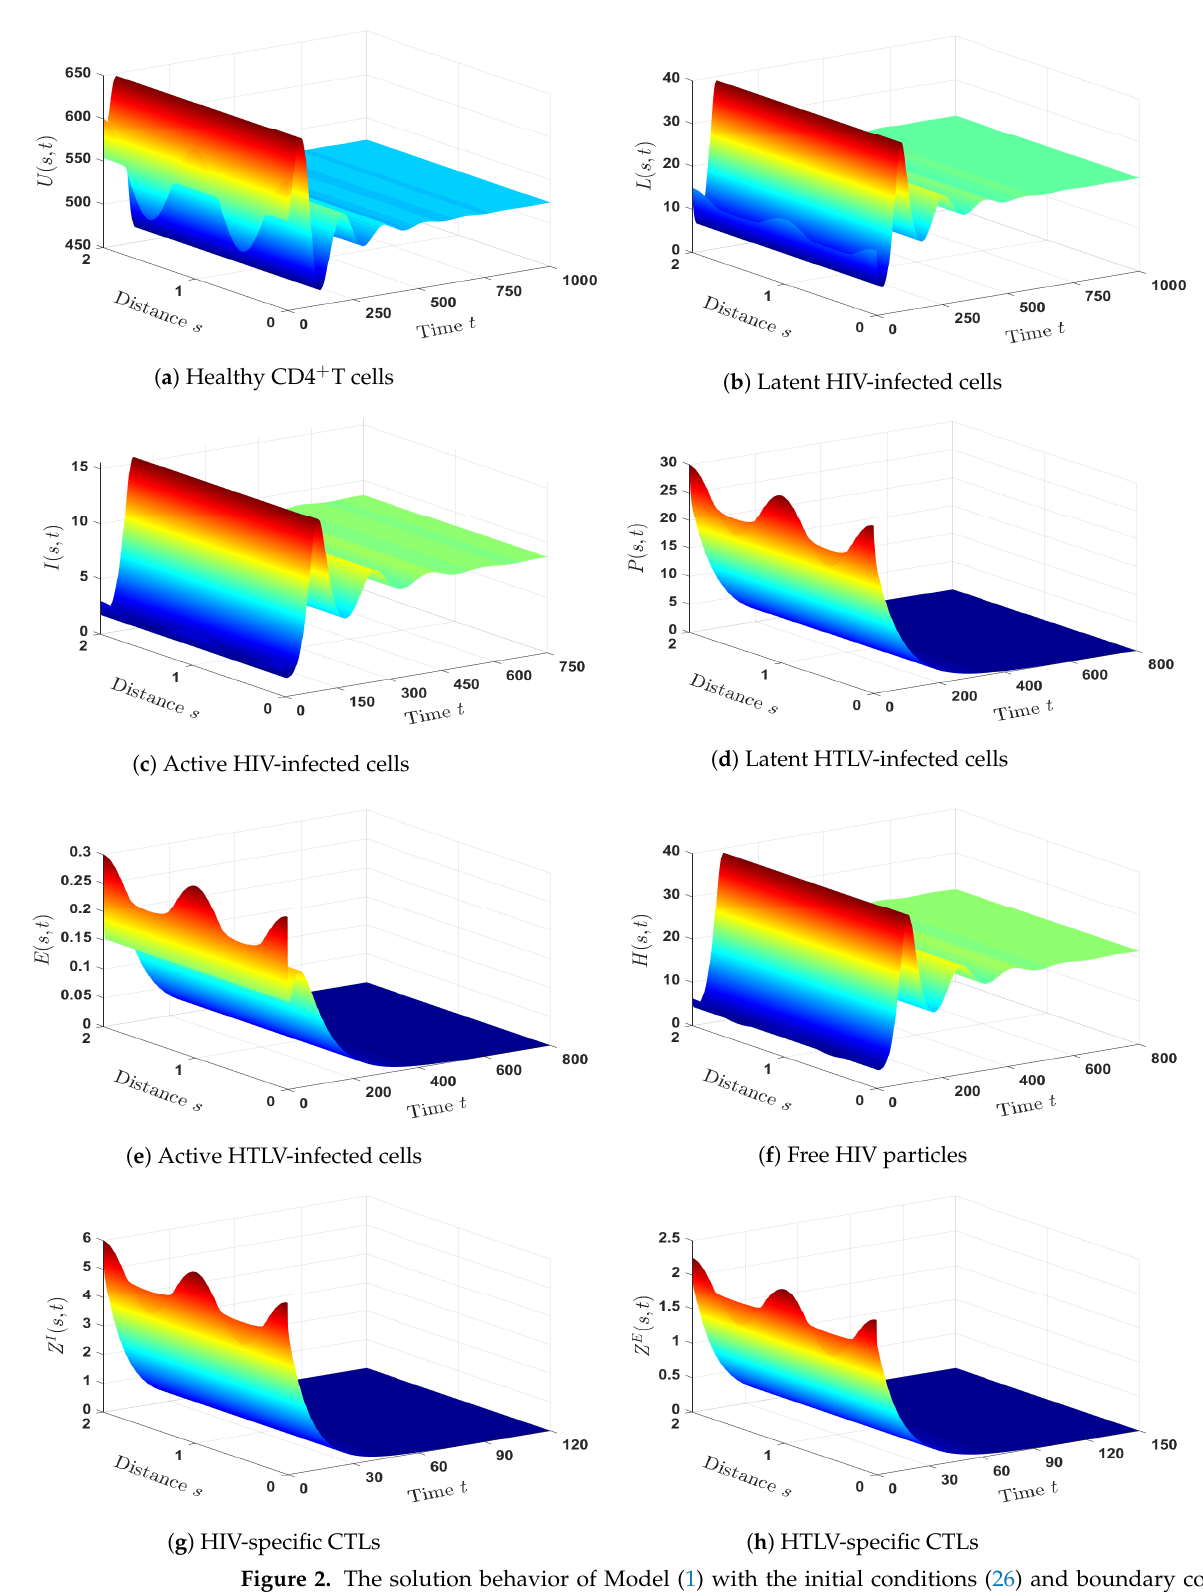
Figure 2. The solution behavior of Model (1) with the initial conditions (26) and boundary con- ditions (27). Taking ω 1 = 0.0001, ω 2 = 0.0002, ω 3 = 0.0003, ω 4 = 0.0005, υ 1 = 0.003, υ 2 = 0.2, we have R 1 = 1.91 > 1, R 2 / R 1 = 0.063 < 1, R 3 = 0.39 < 1, and the equilibrium ˇ S 1 = ( 523.81,21.65,8.66,0,0,21.65,0,0 ) is asymptotically